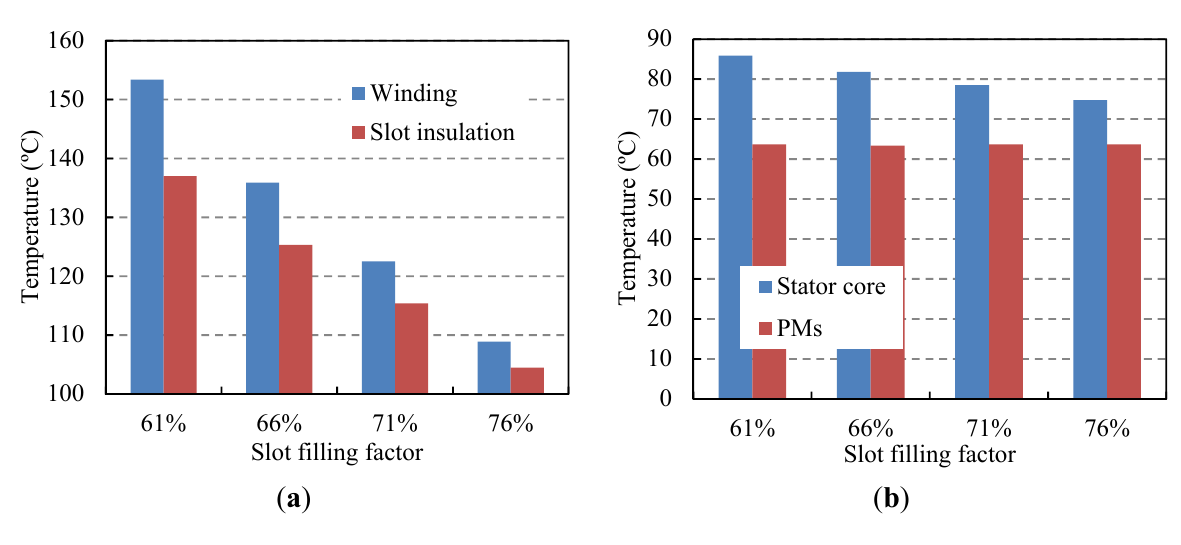
Figure 17. The maximum temperatures of different parts vs. slot filling factor (Case B): ( a ) winding and slot insulation; ( b ) stator core and PMs.